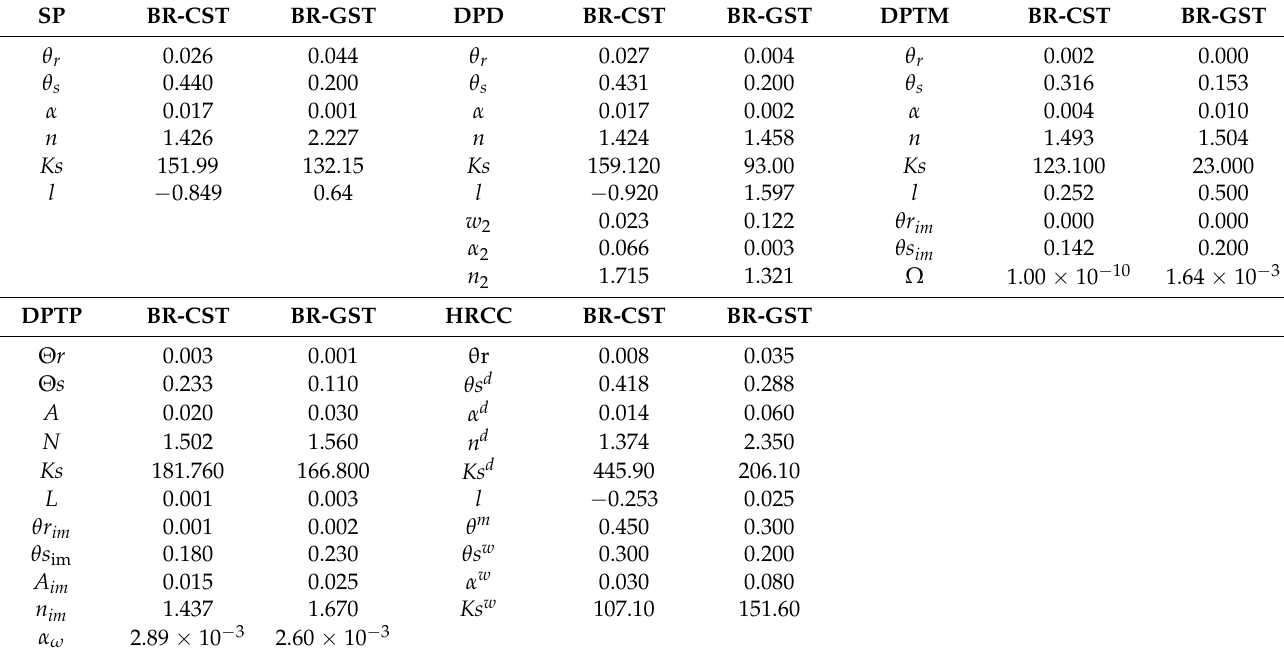
Table 7. Hydraulic parameters of the models adjusted by the inverse method in